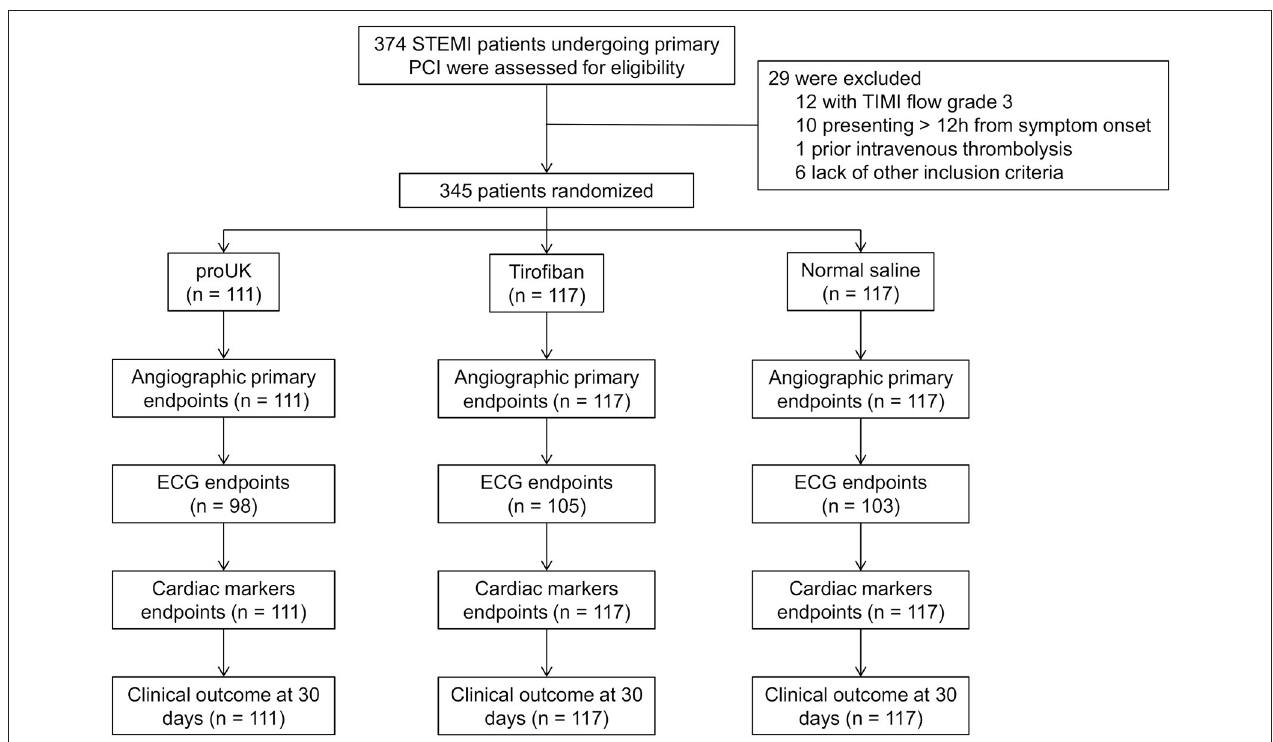
FIGURE 1 | Flowchart showing patient enrollment. PCI, percutaneous coronary intervention; STEMI, ST-segment elevation myocardial infarction; TIMI, thrombolysis in myocardial infarction grade; ECG,